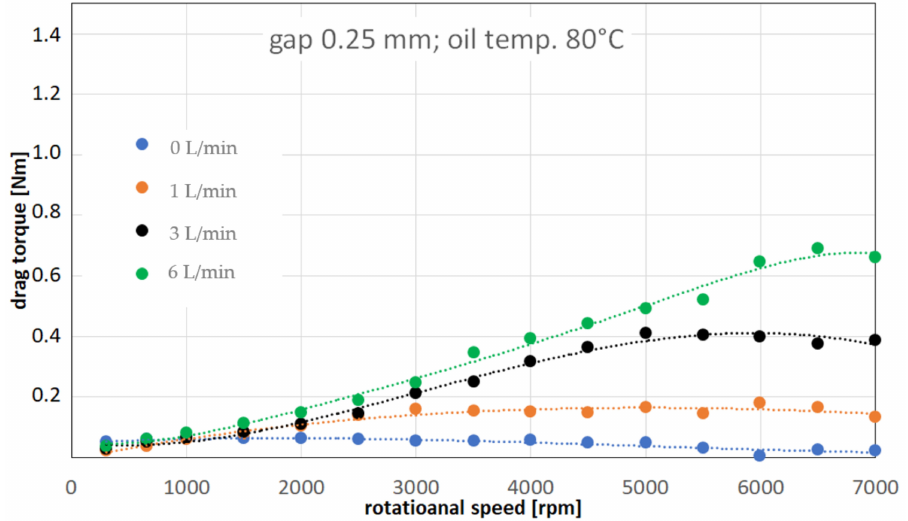
Figure 5. Drag torque characteristics for gap between plates 0.25 mm, oil temperature 80 ◦ C and various values of oil flow